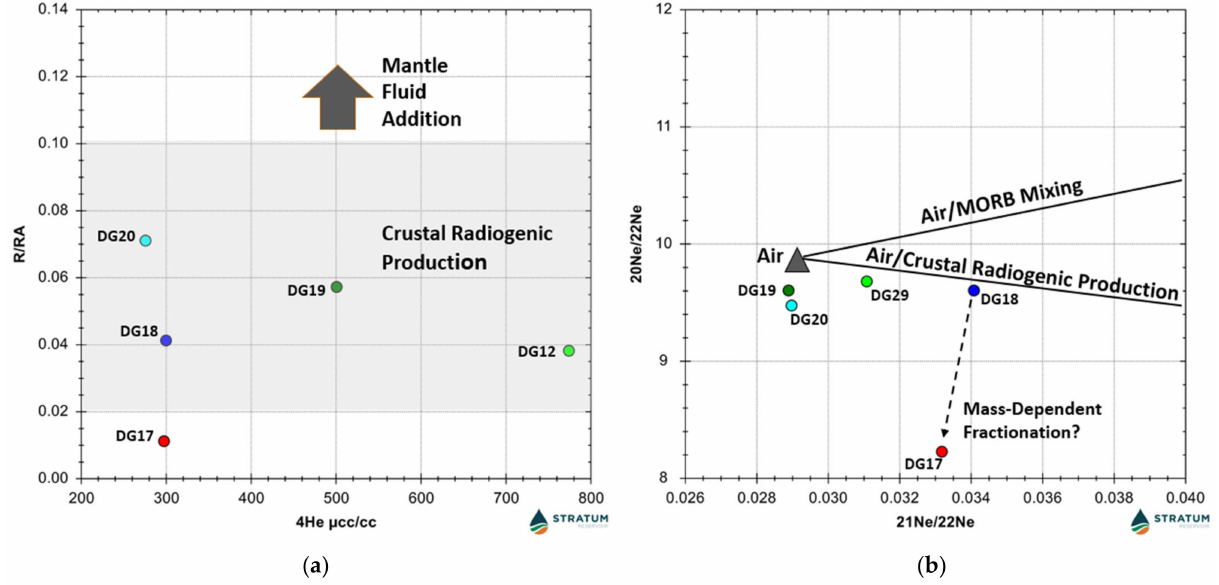
Figure 10. ( a ): Plot of 4 He concentration versus R/R a for five selected dry Marcellus Formation produced gases collected in northeastern Pennsylvania (Table 4). ( b ) 21 Ne/ 22 Ne versus 20 Ne/ 22 Ne for the five Marcellus Formation dry gases